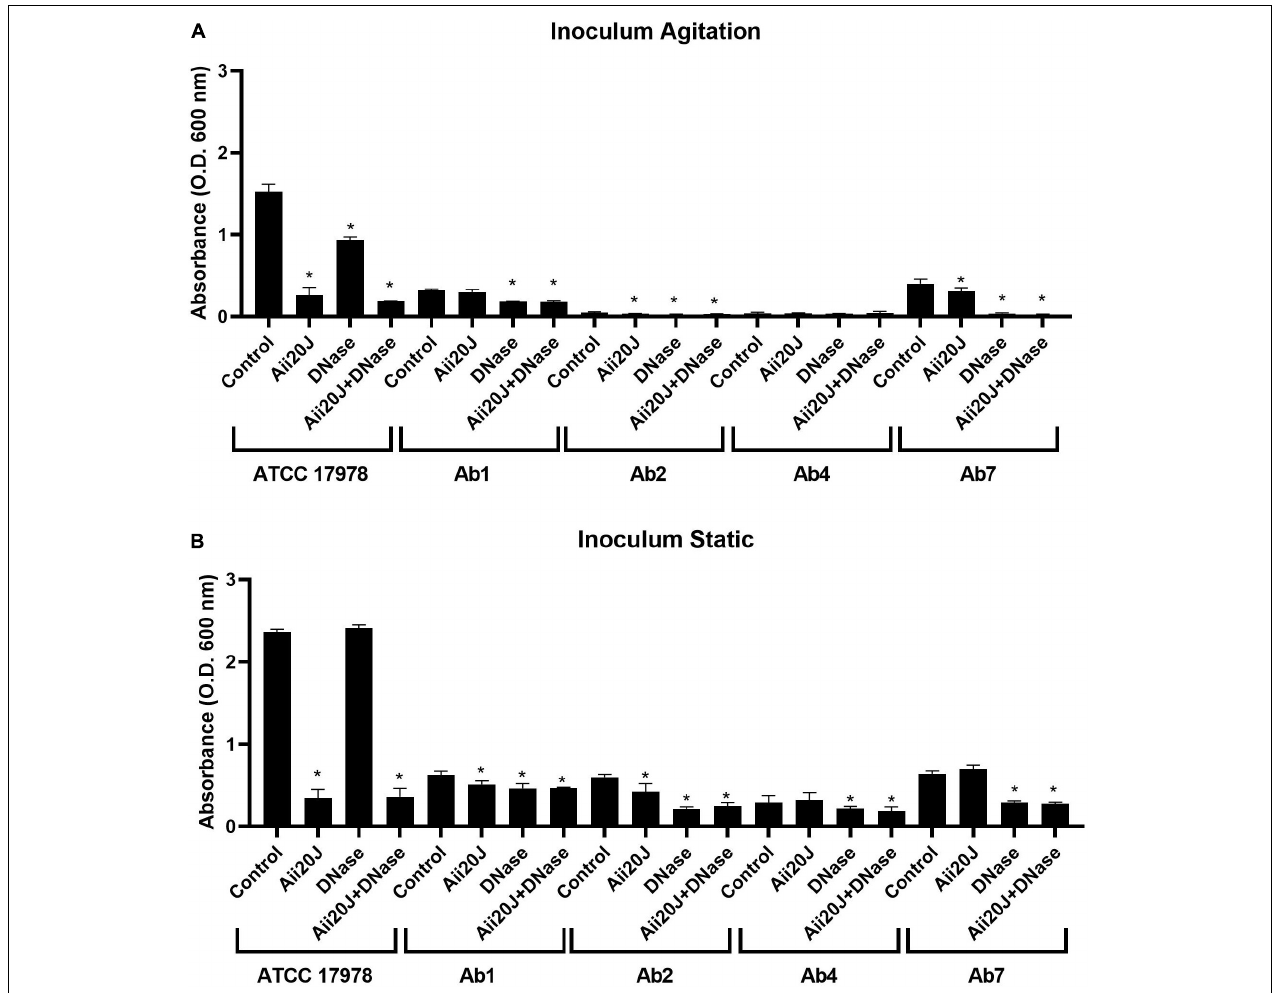
FIGURE 6 | Effect of the QQ enzyme Aii20J (20 µ g/mL), DNase (2 U/mL) or both on biofilm formation by A. baumannii ATCC R (cid:13) 17978 TM and different multidrug-resistant clinical strains presenting different motility patterns (López et al., 2017). Biofilms were cultivated on 18 mm × 18 mm glass coverslips in LS-LB during 24 h at 37 ◦ C and stained with crystal violet ( n = 3). The cultures were inoculated with cells from an agitated (A) or a static (B) culture. Asterisks indicate statistically significant differences in comparison with the untreated control (Mann–Whitney test, p <